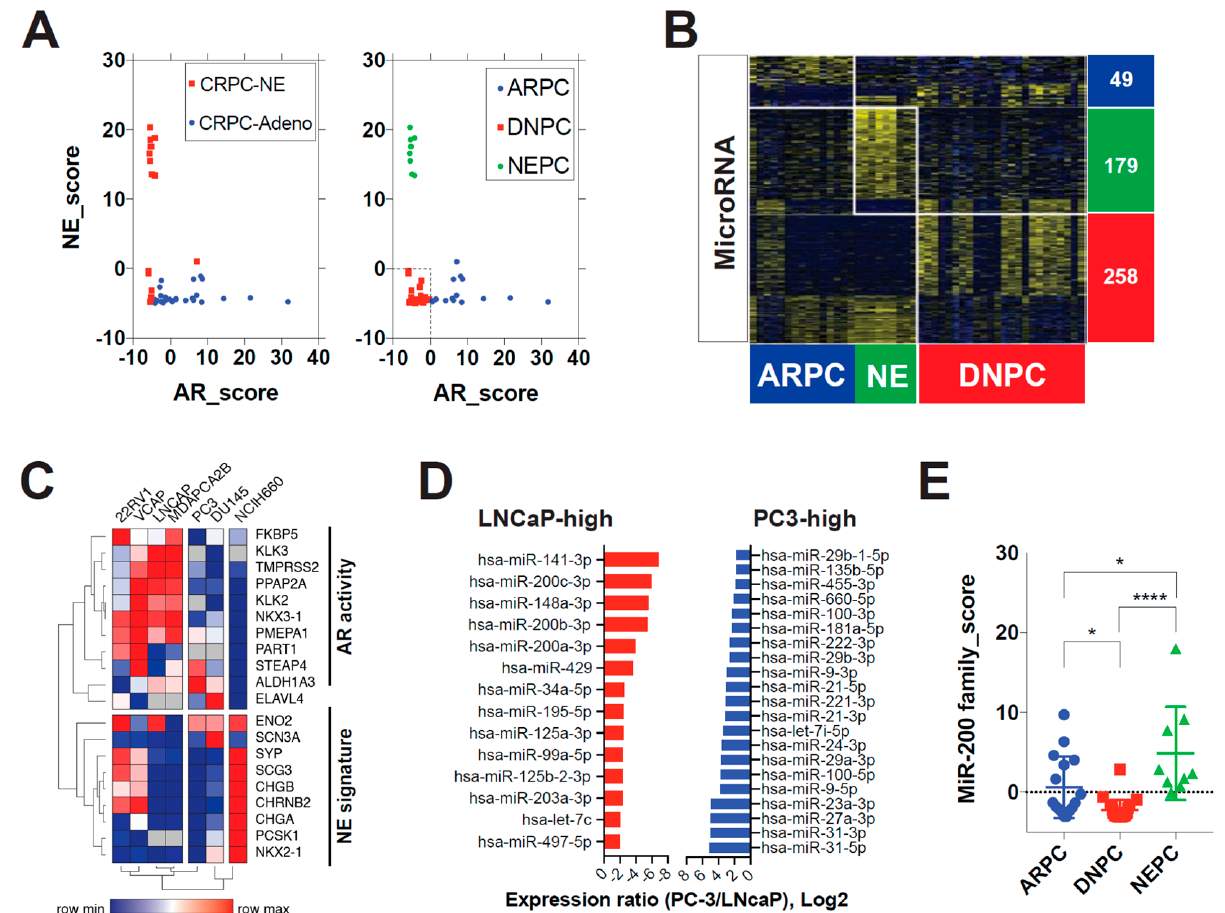
Figure 1. MiR-200 family expression is repressed in double-negative prostate cancer. ( A ) Molecular subtype classification applied to the Weil-Cornell-Medicine (WCM) CRPC dataset. Left: Histologic classification; Right: Gene expression-based classification. CRPC-NE = Castration-resistant prostate neuroendocrine carcinoma; CRPC-Adeno = Castration-resistant prostate adenocarcinoma. NE_score = mRNA expression z-score sums of 10 neuroendocrine signature genes. AR_score = mRNA expression z-score sums of 10 androgen receptor (AR) target genes. ARPC = AR-positive prostate cancer; DNPC = Double-negative (not expressing AR nor neuroendocrine markers) prostate cancer; NEPC = NE marker-positive prostate cancer. ( B ) Subtype-specific microRNA signatures for prostate cancer in the WCM dataset. Expression patterns of microRNAs according to molecular subtypes of prostate cancer (AR/NE/DN). Heatmaps for microRNA and mRNA show distinct expression patterns along with molecular subtype. Subtype-specific signatures were extracted by multiple t -tests between the subtype of interest and the other subtypes (Cut-off: p < 0.05). ( C ) Cell line model of DNPC. Hierarchical clustering by using AR activity and NE signature genes. Average Spearman rank clustering method was used. DNPC = double-negative prostate cancer, AR = androgen receptor; NE = neuroendocrine. ( D ) Top overexpressed miRs in LNCaP and PC3 cell lines. miR = microRNA. ( E ) MiR-200 family expressions in the WCM dataset. MiR-200 family_score = mRNA expression z-score sums of 5 miR-200 family genes. * p < 0.05; **** p < 0.0001.